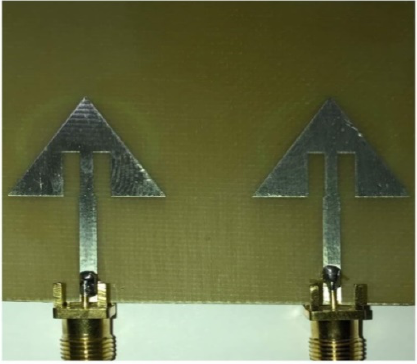
The proposed antennas described in the previous section were first designed and tuned in HFSS. They were then fabricated for the MIMO configuration as shown in Fig.6 (a), (b) showing the top and bottom layer.